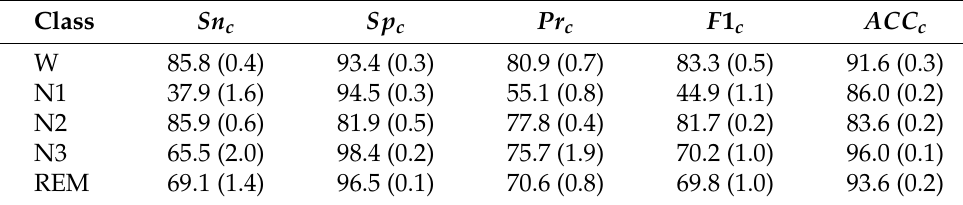
Table 3. Detailed per-class best test performance obtained with CWT-TF representation from C4-M1 using CNN transfer learning network. Results are reported as the mean (std) for three trials.